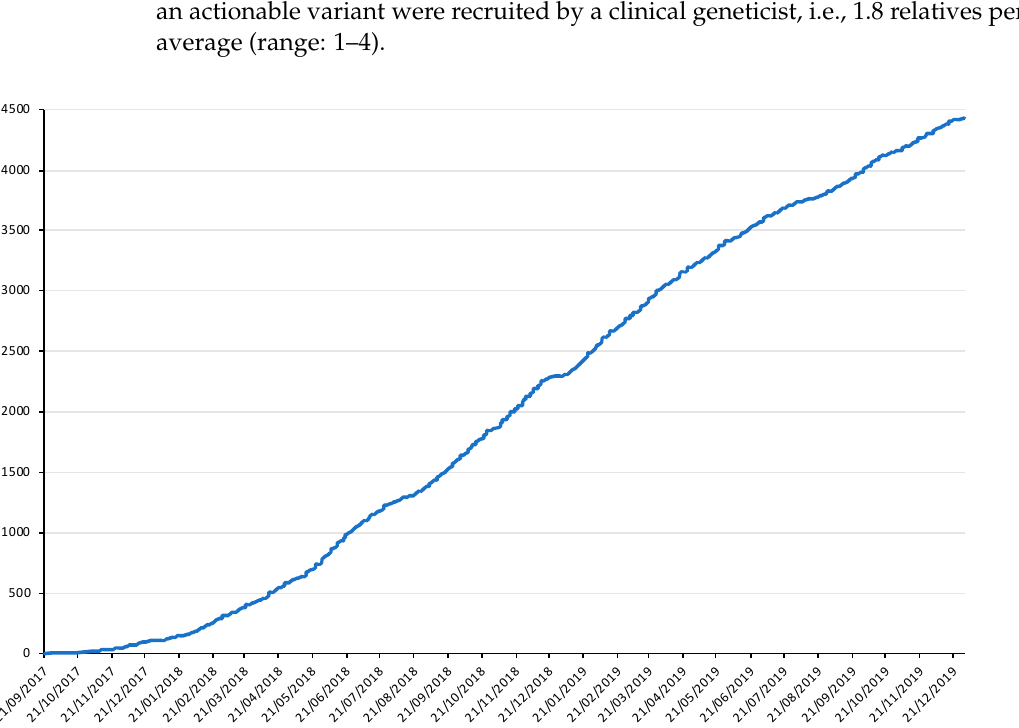
Figure 2. Dynamics of recruitment of prospective index cases during the feasibility study (September 2017–December 2019). X axis: calendar time scale; Y axis: cumulative number of index cases enrolled in the study.